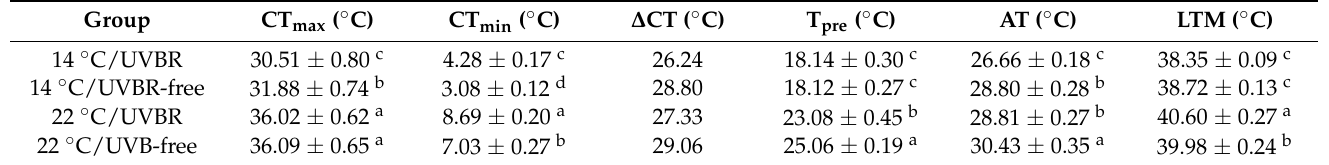
Table 2. Variation in the critical thermal maximum, critical thermal minimum, thermal tolerance range, preferred temperature, avoidance temperature, and lethal thermal maximum of R. kukunoris tadpoles. All data are represented in mean ± SE. CTmax: critical temperature maximum; CTmin: critical temperature minimum; ∆ CT: critical temperature range; Tpre: preferred body temperature; AT: avoid temperature; LTM: lethal temperature maximum. Lowercase letters denote significant differences between